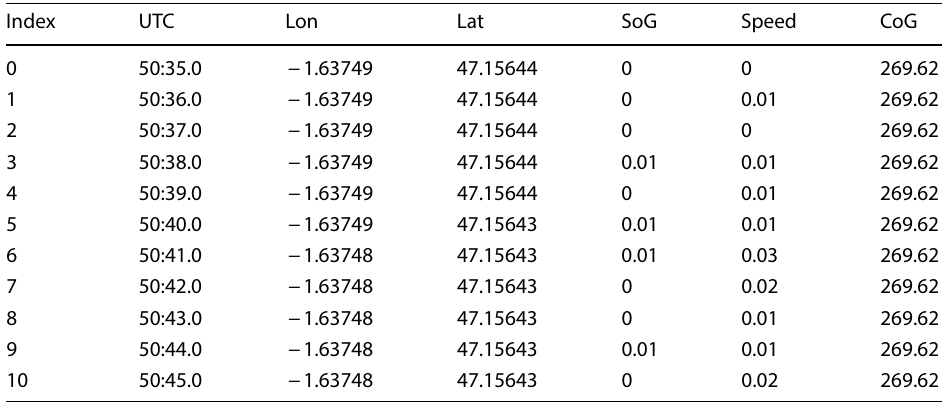
Table 3 Positioning data collection based on UBlox